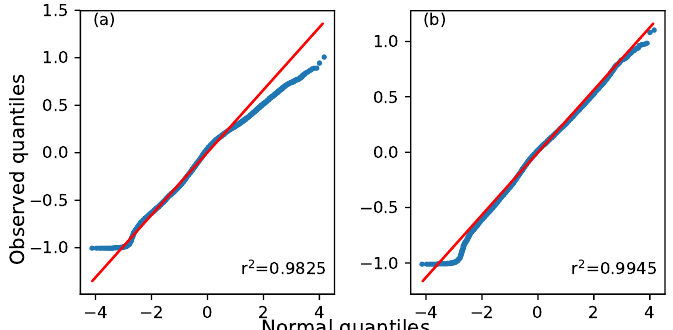
Figure 14. Quantile-quantile plot of relative daily emission data with squared correlation coefficient r 2 . Red line shows the expected distribution if the residuals are perfectly normally distributed. ( a ) Relative emissions with no weekly factor adjustment. ( b ) Relative emissions with weekly cycle removed.